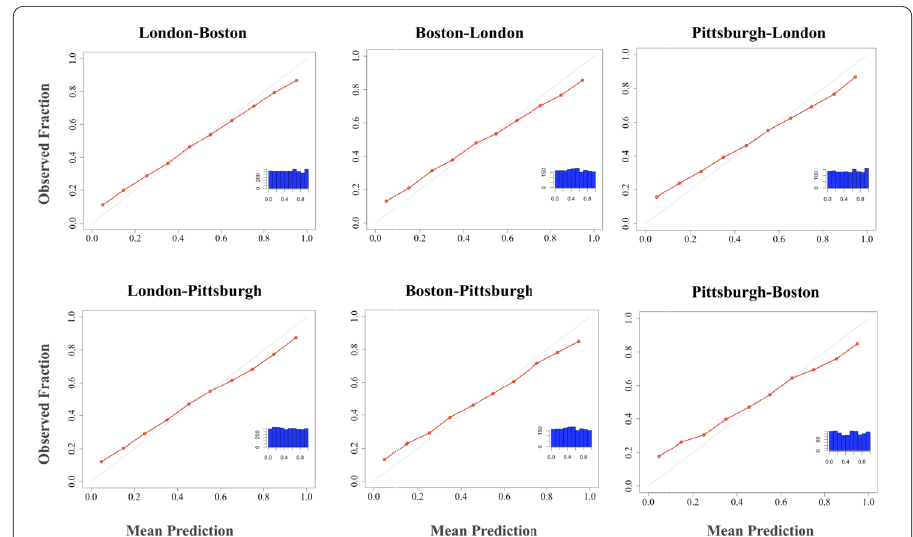
Figure 4 Calibration curves for out-of- city severe biking accident